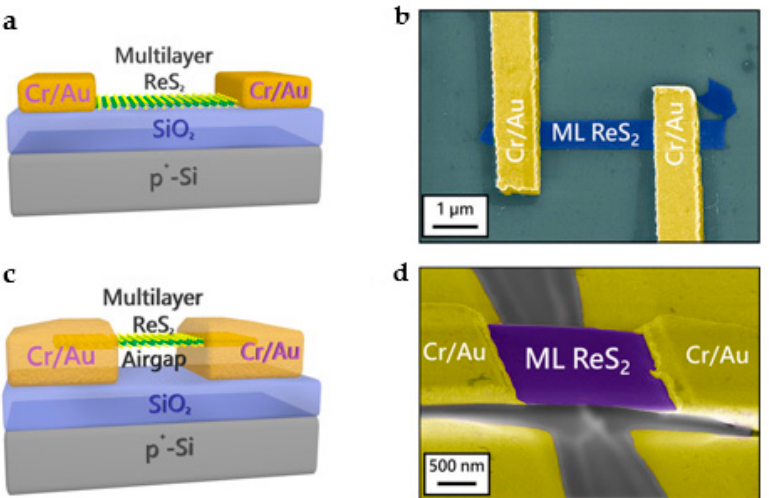
Figure 12. ( a ) Schematic diagram of the supported ReS 2 transistor (ReS 2 in contact with the SiO 2 gate medium) and ( b ) false color SEM image. ( c ) Schematic diagram of a suspended ReS 2 transistor (with an air gap between ReS 2 and SiO 2 gate) and ( d ) false color SEM image (Reprinted with permission from ref. [150]. Copyright 2018, American Chemical Society Publications).